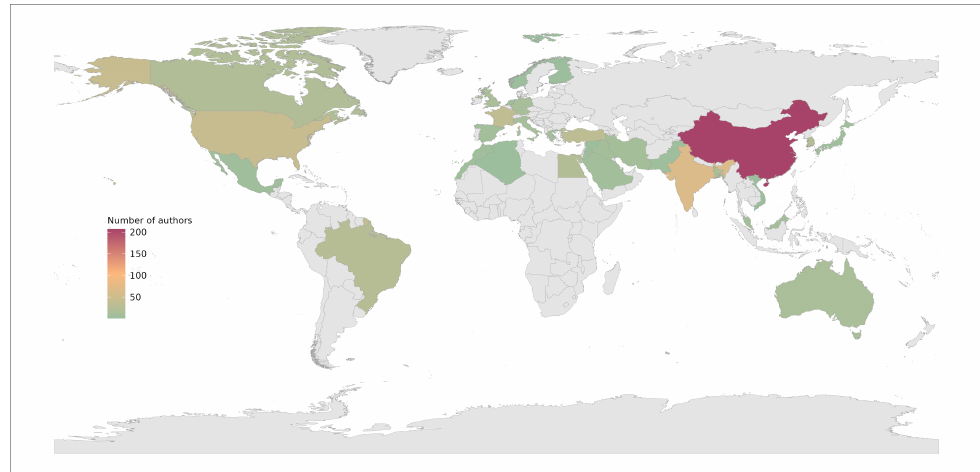
Figure 4. Distribution of authors by country.